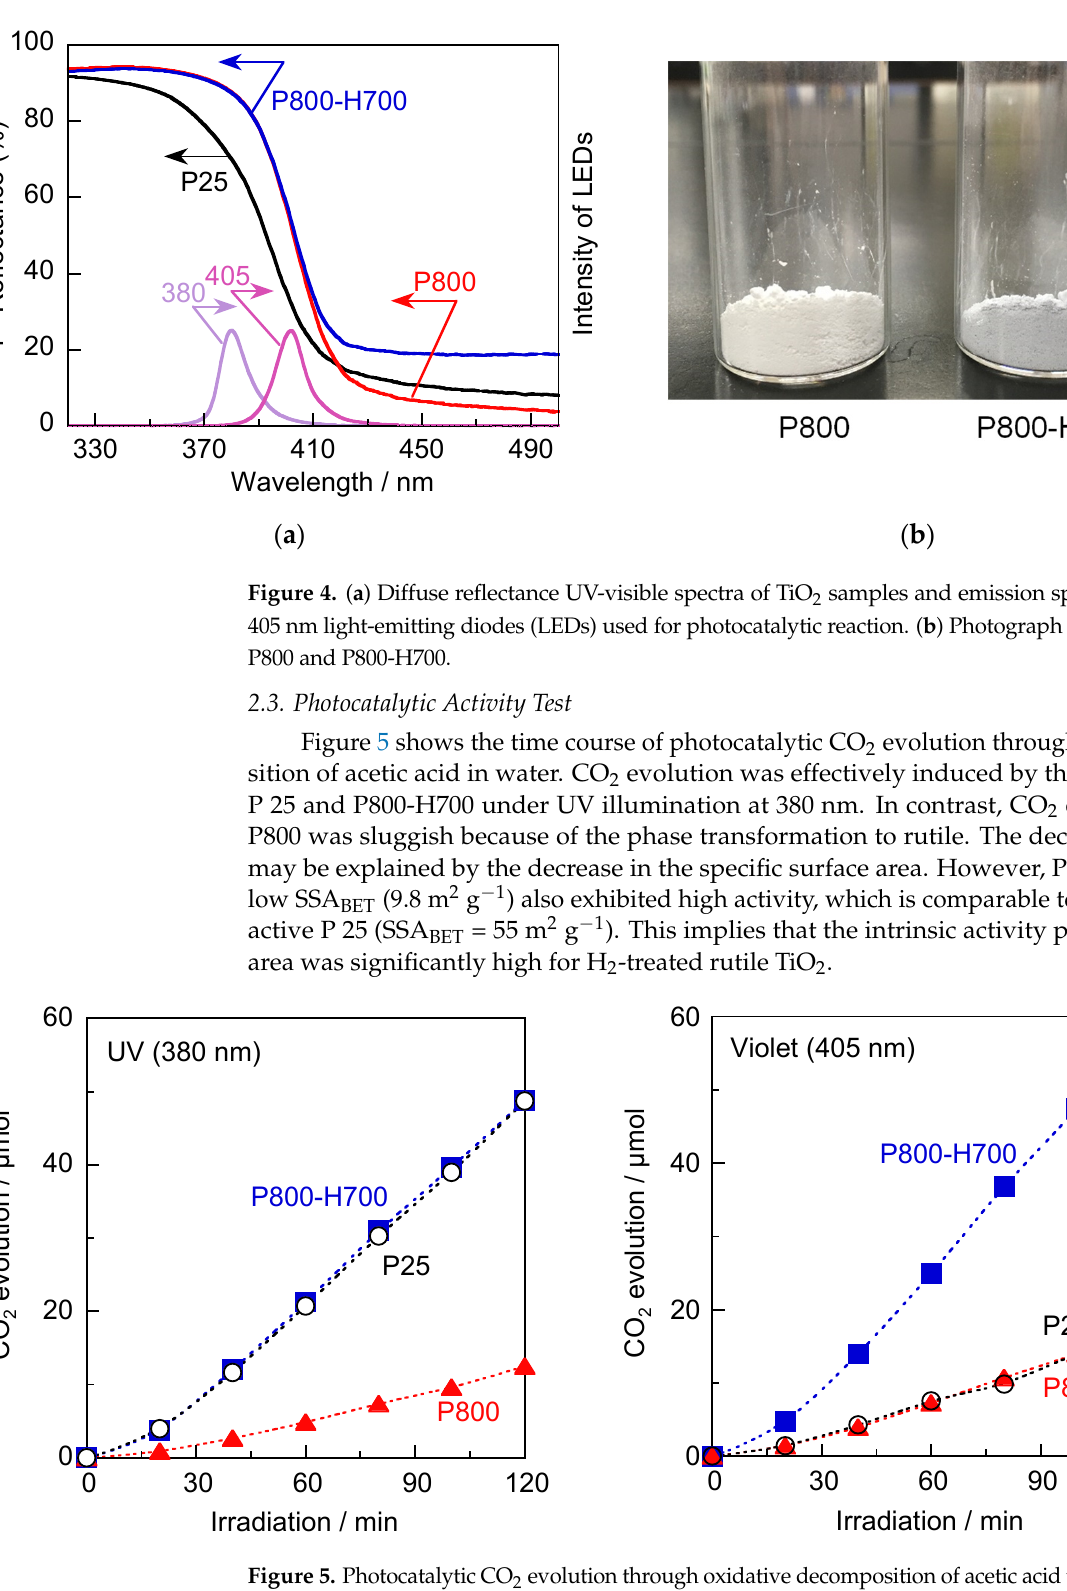
Figure 5. Photocatalytic CO 2 evolution through oxidative decomposition of acetic acid under ( a ) 380-nm UV irradiation (9 mW cm − 2 ) and ( b ) 405-nm violet light irradiation (18 mW cm − 2 ). Photocatalyst: 50 mg, liquid phase: 1 vol% CH 3 COOH aq. (9.0 mL), gas phase: Oxygen (15 mL), and temperature 25 °C.